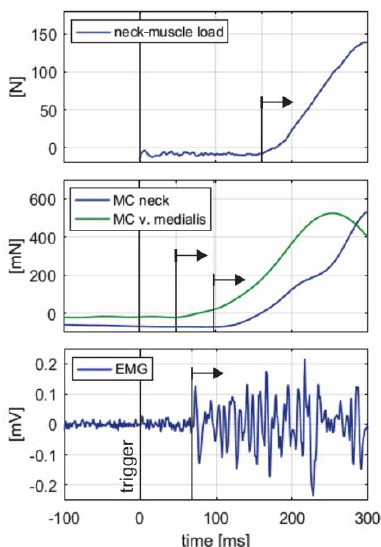
Figure 5. An example of onset latencies for the neck-muscle load F, MC neck and MC v. medialis (indentation force of the tip of the sensor), and EMG signals from a single trial. Black arrows indicate visually determined onset for each of the signals collected. Note that F was estimated based on inverse dynamics analysis of the head-neck motion from the instant of impact (trigger). Table 4. Onset latencies for EMG, MC neck, MC vastus medialis, and neck-muscle load F from the instant of the impact [ms]; mean ± SD, median (min / max), p -value for pairwise comparisons between aware and unaware